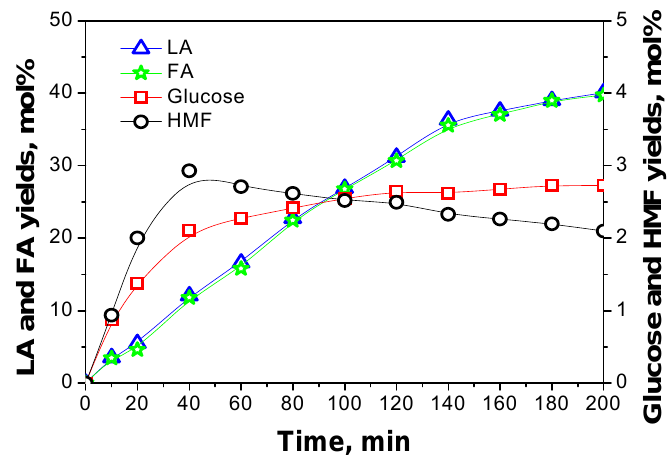
-catalyzed hydrolysis of 3